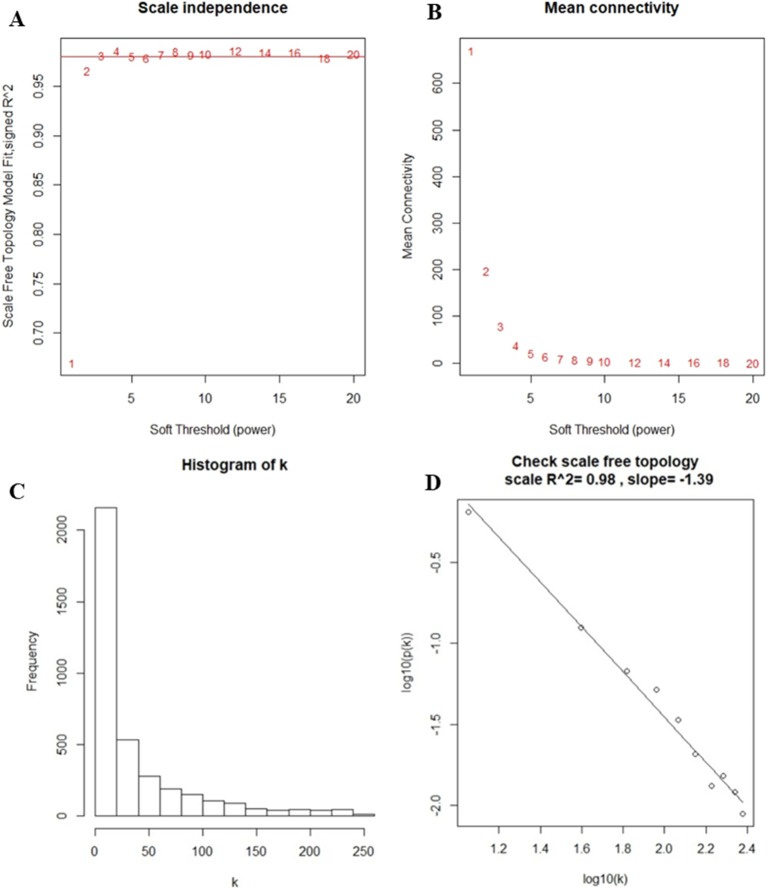
Determination of soft-thresholding power in the weighted gene co-expression network analysis. (A) Analysis of the scale-free fit index for different soft-thresholding powers (β). Numbers in the plots represent the corresponding soft-thresholding powers. The approximate scale-free topology can be obtained at a soft-thresholding power of 4. (B) Analysis of the mean connectivity for different soft-thresholding powers. (C) Histogram of connectivity distribution when β = 4. (D) Checking the scale-free topology when β = 4.